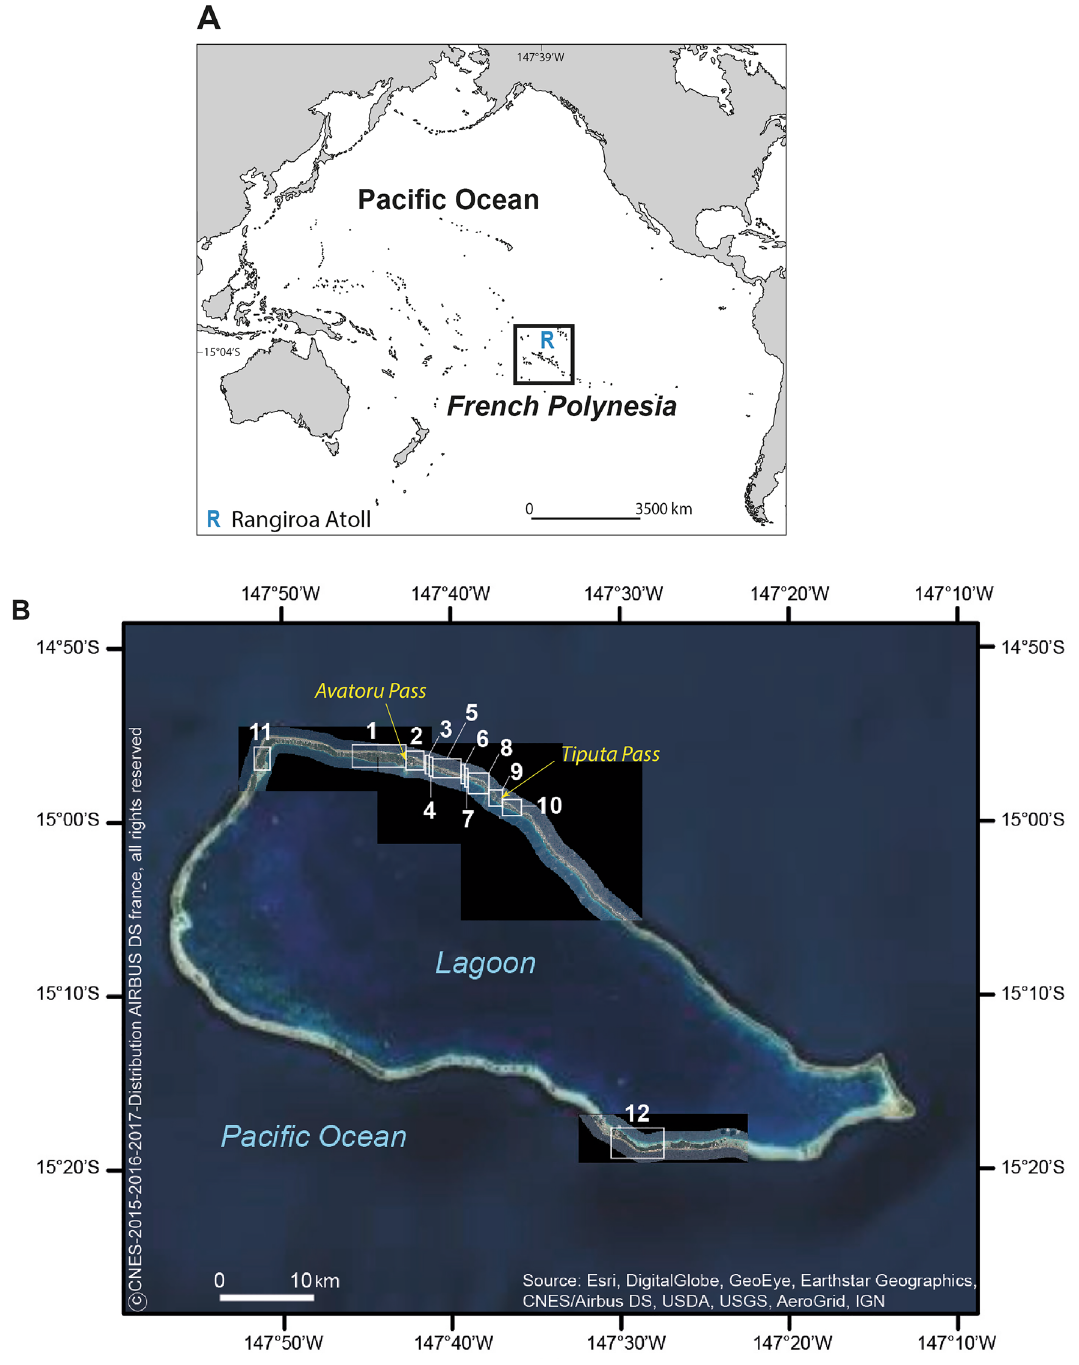
Figure 2. Study area. ( A ) Shows the location of Rangiroa Atoll in the Tuamotu Archipelago. On ( B ), study islands are numbered in a clockwise direction. This panel shows the location of the settled (Nos. 2–10) and unsettled (Nos. 1, 11 and 12)